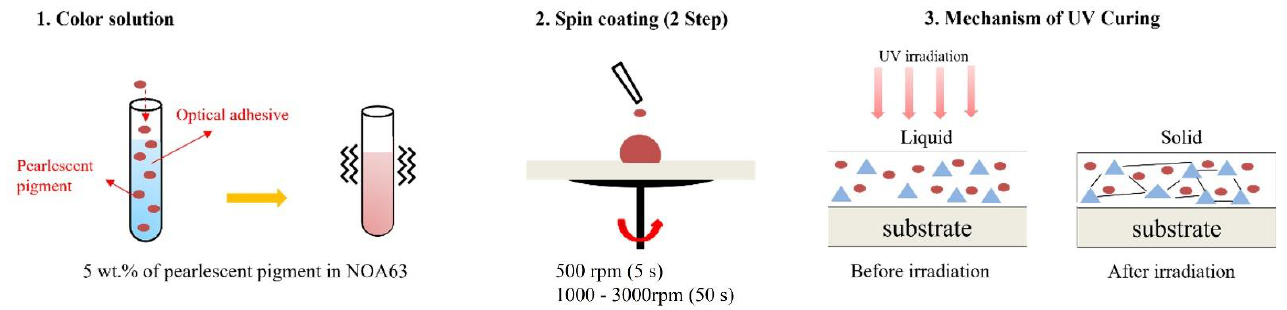
Figure 1. Solution formulation and colored glass fabrication process.